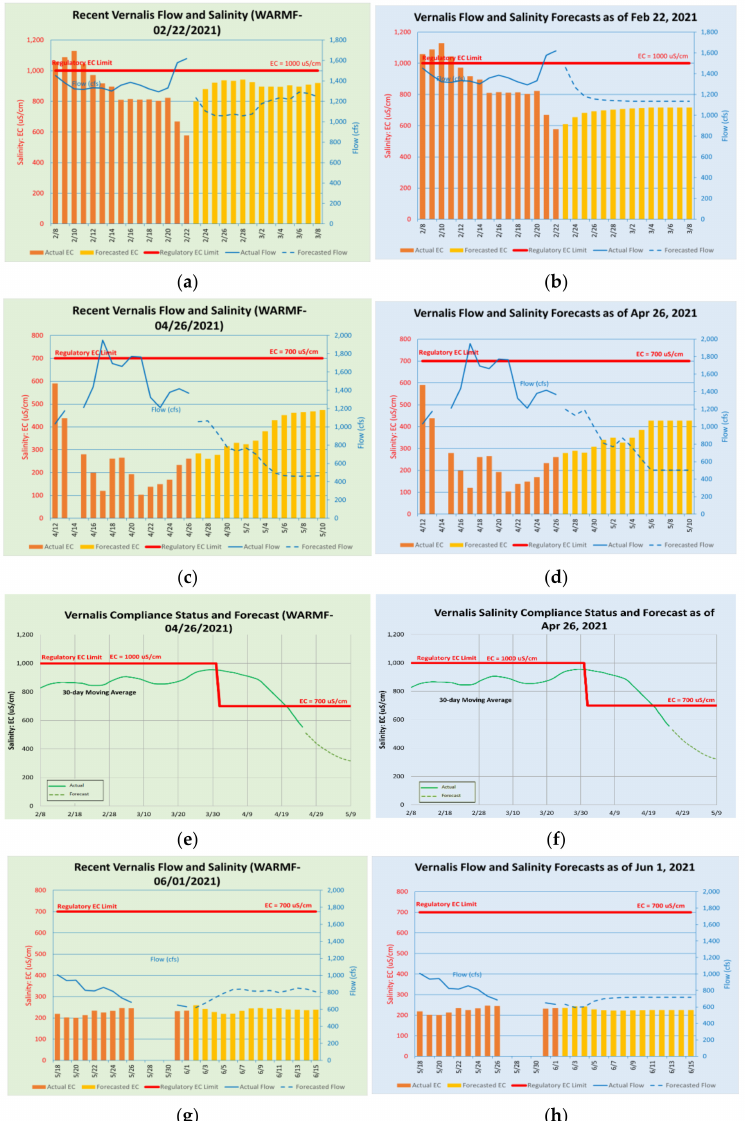
Figure 17. Comparison of daily WARMF and Regression model forecasts for EC at the Crows Landing compliance monitoring station on 22 February 2021 ( a,b ); 26 April 2021 ( c,d,e,f ); and 1 June 2021 ( g,h ). Graphs ( e,f ) show the 30-day running average EC forecast on 26 April 2021 relative to the the 30-day running average EC compliance objective. Conversion of flow in cfs to m 3 /s: 100 cfs = 2.83 m 3